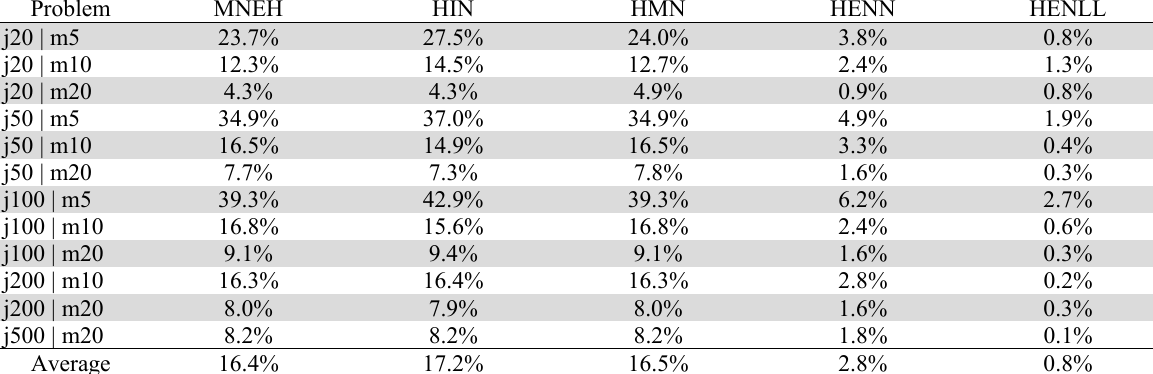
Relative deviation of heuristics with preventive maintenance policy